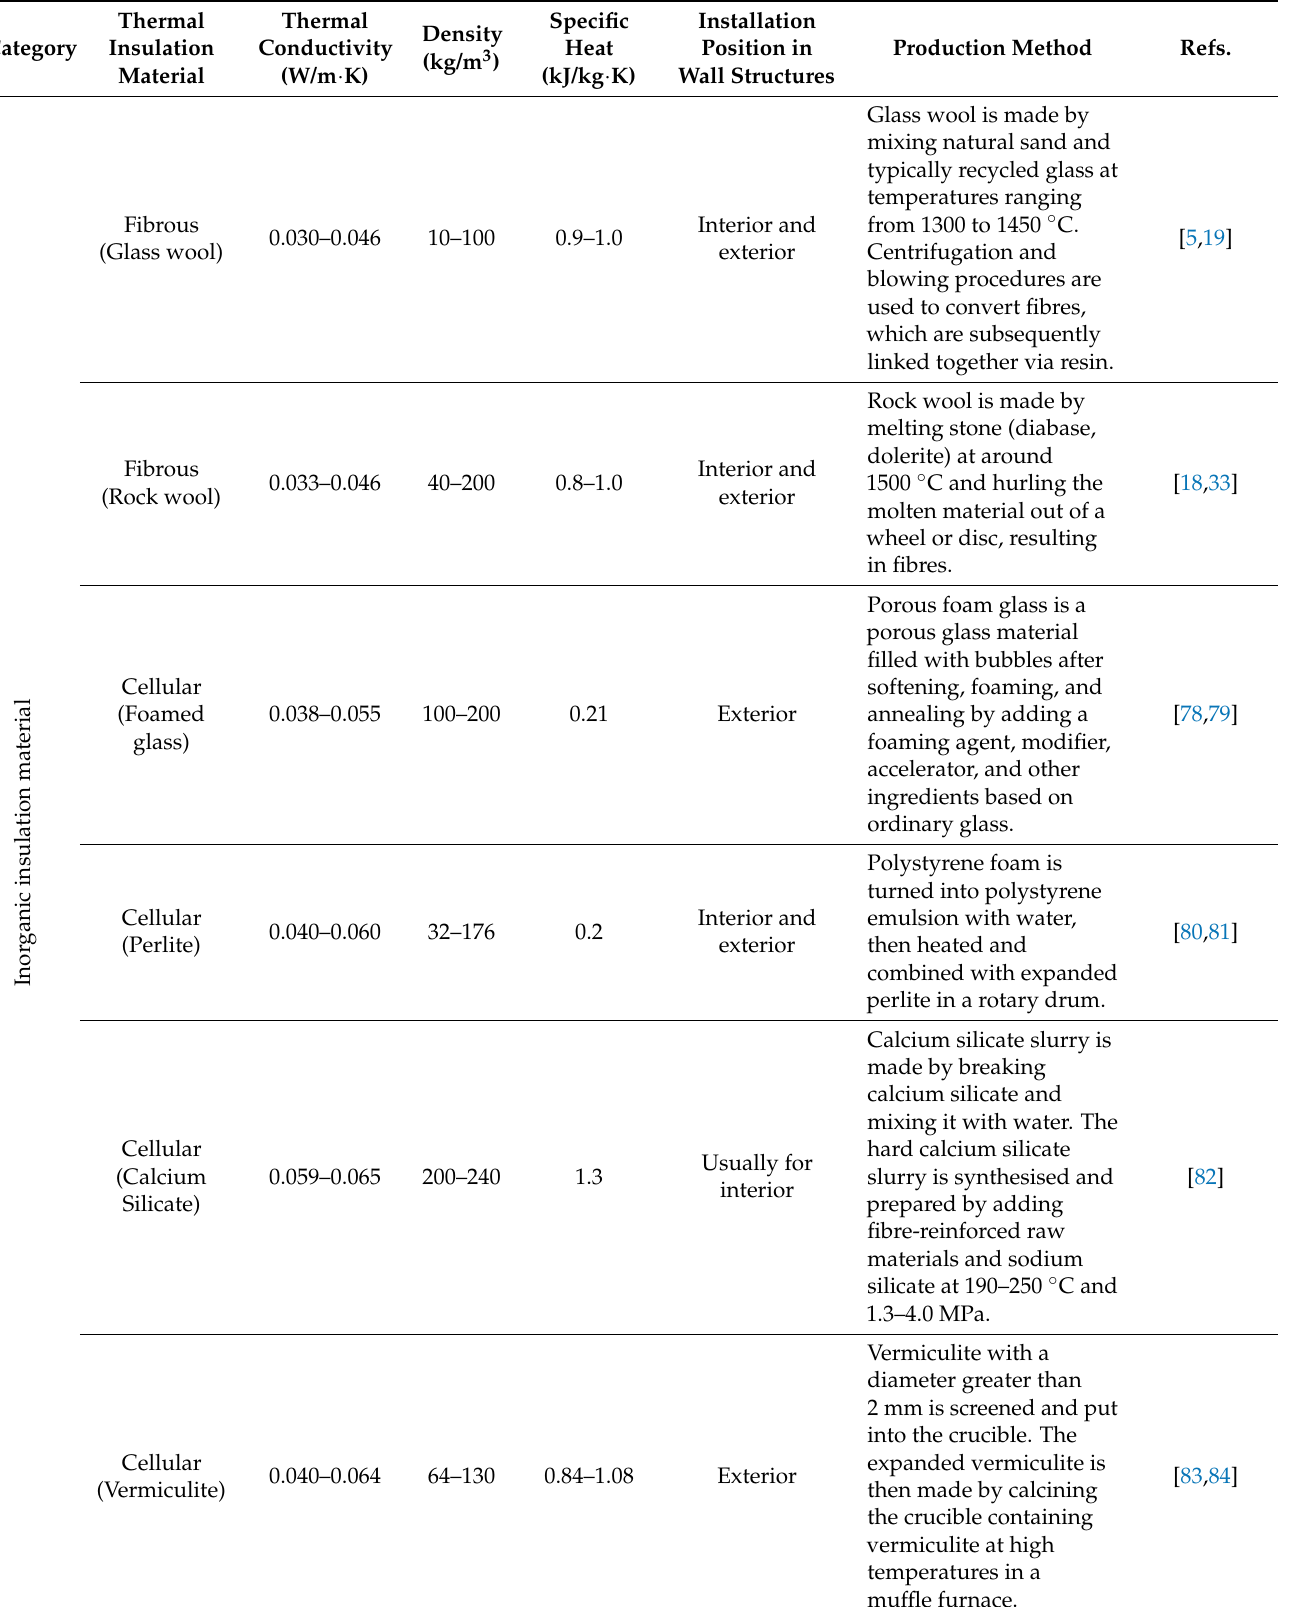
Table 1. Main characteristics and production process of building thermal insulation